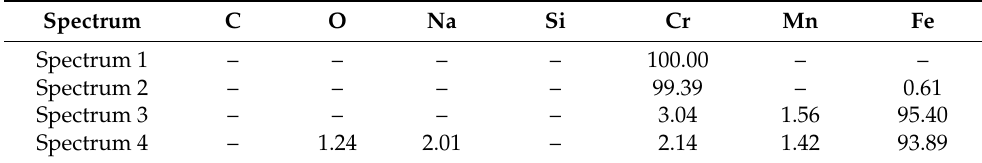
Table 3. Element content at each scanning point of the specimen with chromium plating coating (wt.%).